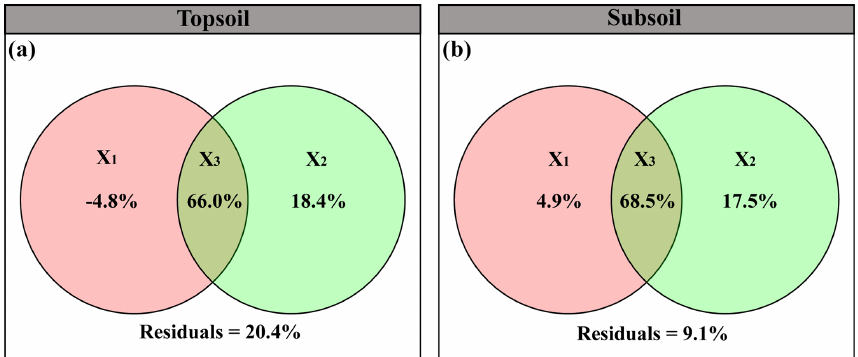
Figure 5. Variation partitioning analyses (VPAs) reveal the relative contribution of abiotic and biotic variables to SIC density in the (a) topsoil (61.2% vs. 84.4%) and (b) subsoil (73.4% vs. 86.1%), respectively. Results in three fractions: the unique effect of abiotic factors (X1), the unique effect of biotic factors (X2), and common interception of abiotic and biotic factors